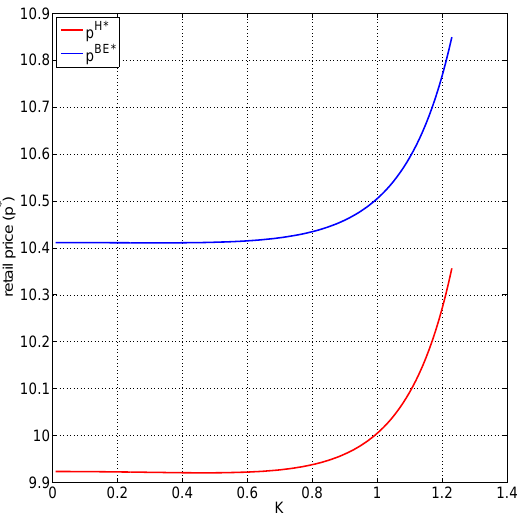
Figure 6. The influences of K on the retail price p .